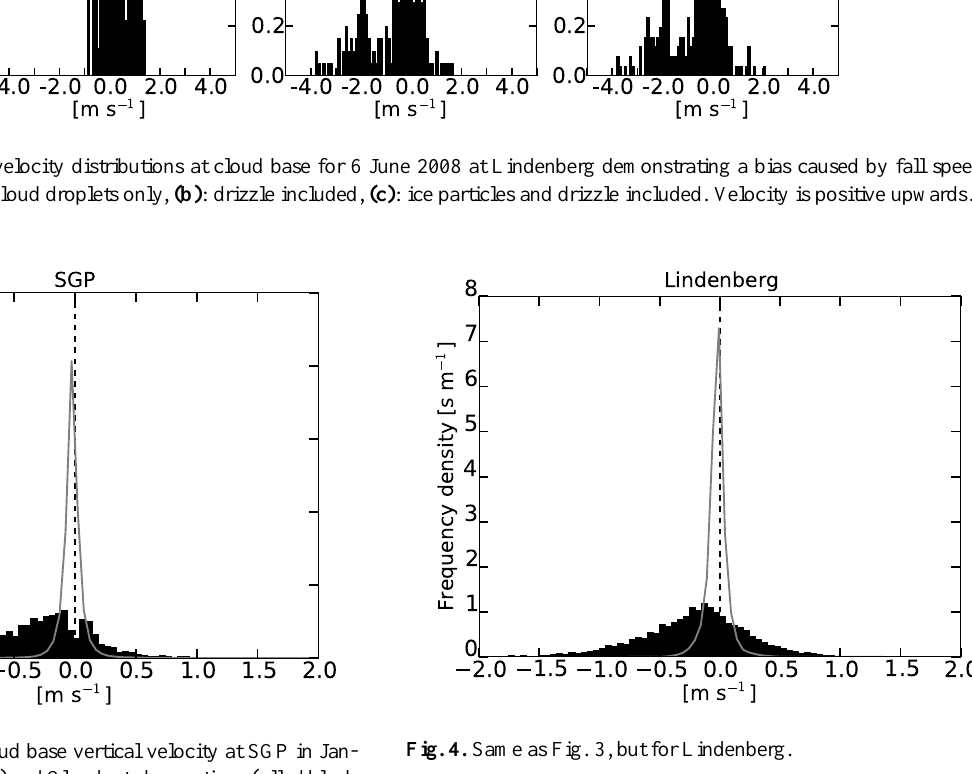
Fig. 3. Distribution of cloud base vertical velocity at SGP in Jan- uary for AROME (grey line) and Cloudnet observations (filled black bars) for cloud bases between 1000 and 1500 m. The vertical ve- locity bin width is 0 . 05 m s − 1 in both cases.